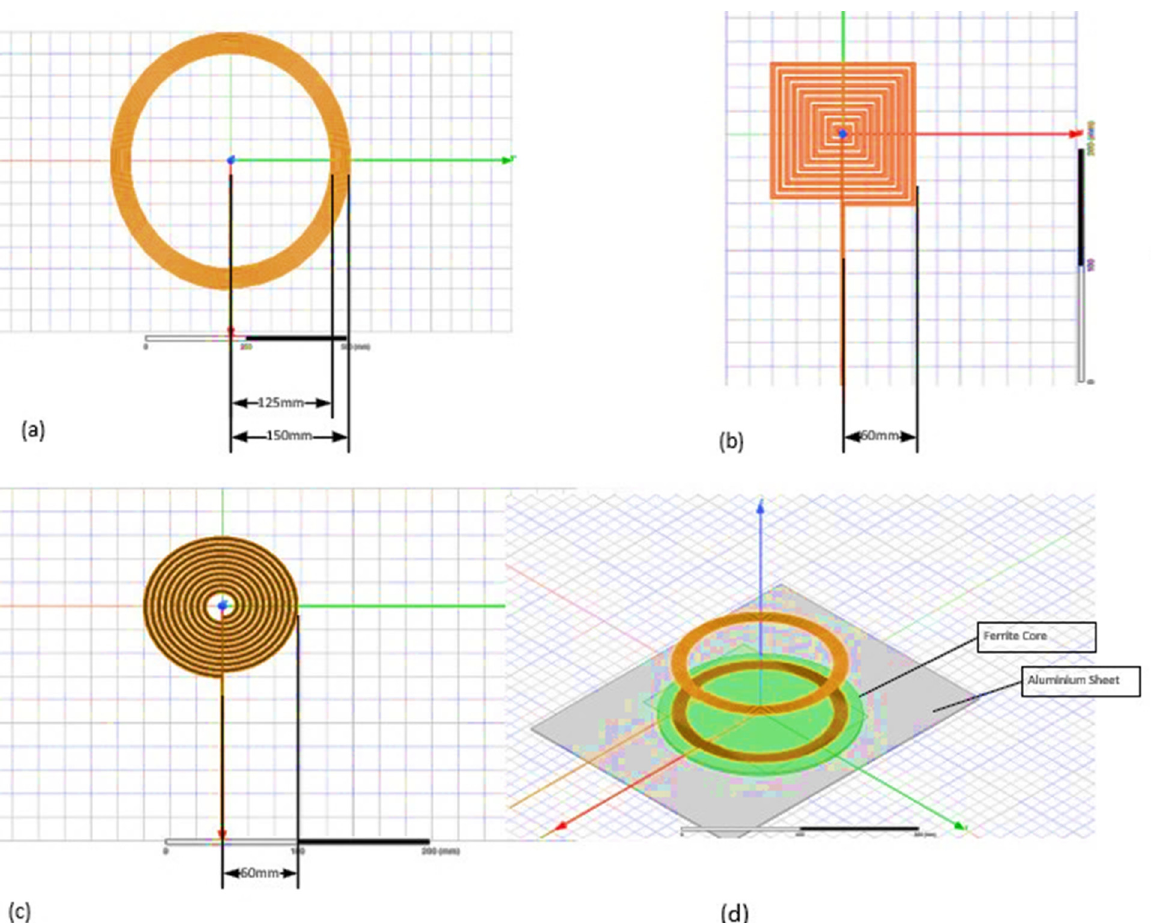
Figure 3. Simulation designs of transmitter and receiver coils: ( a ) 120 mm diameter spiral coil geometry. ( b ) 120 mm diameter square coil geometry. ( c ) 300 mm diameter spiral coil geometry. ( d ) Setup including aluminum and ferrite coil.